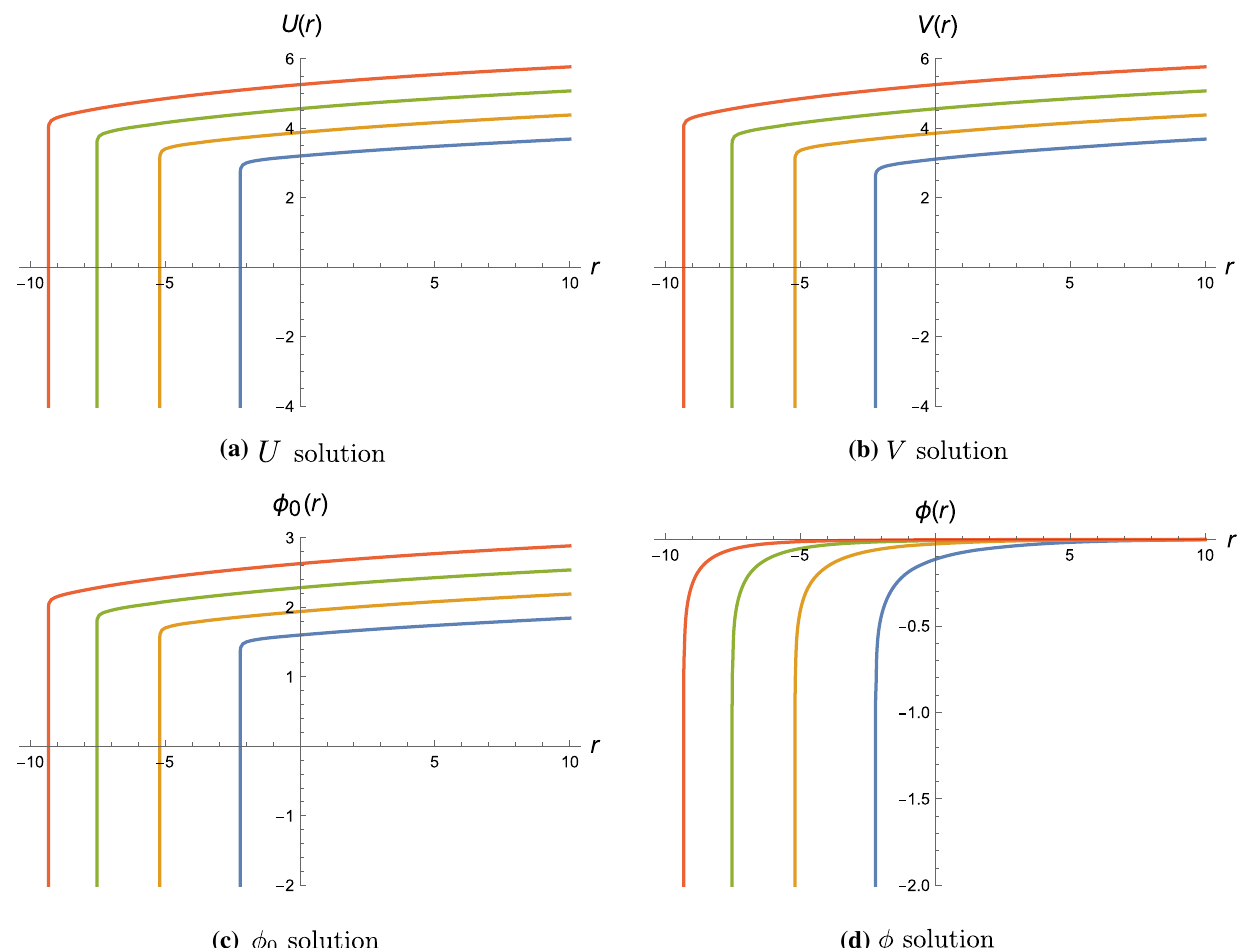
Fig. 35 Supersymmetric flows interpolating between asymptotically locally flat domain walls and Mk w 3 × S 3 -sliced curved domain walls for SO ( 3 ) twist in SO ( 4 ) gauge group. The blue, orange, green and red curves refer to g = 4 , 8 , 16 , 32,